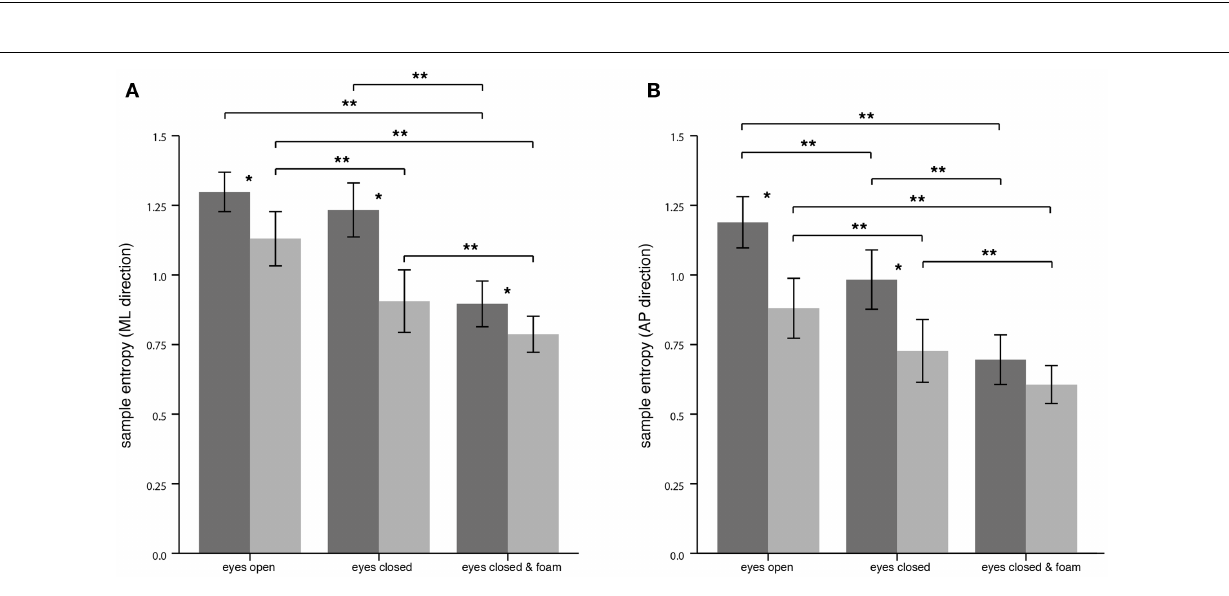
FIGURE 4 | Sample entropy of the center of pressure displacement in the medial-lateral (ML) direction (A) and in the anterior-posterior (AP) direction (B) for healthy controls ( n = 20; dark gray) and patients ( n = 20, light gray) . Asterisks denote significant differences: ( * ) indicates p < 0.05, ( ** ) indicates p <